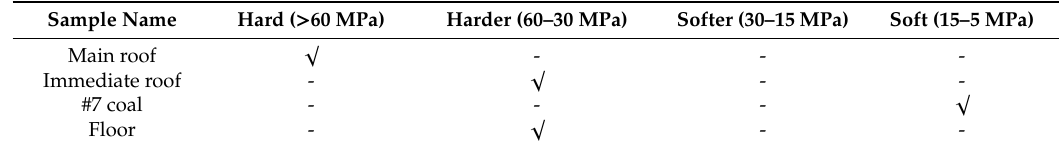
Table 2. The classification of mechanical properties on coal-rock